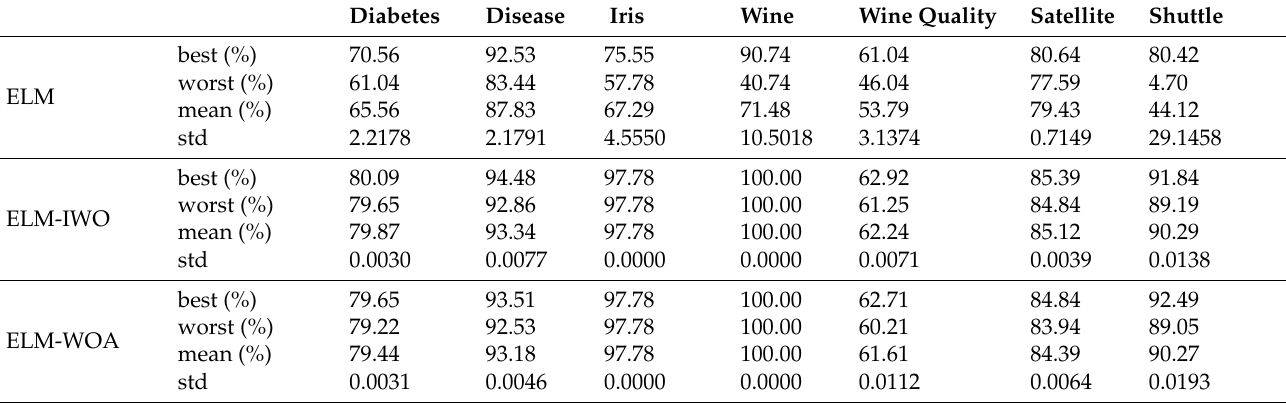
Table 4. Accuracy comparative analysis for simulations with 90